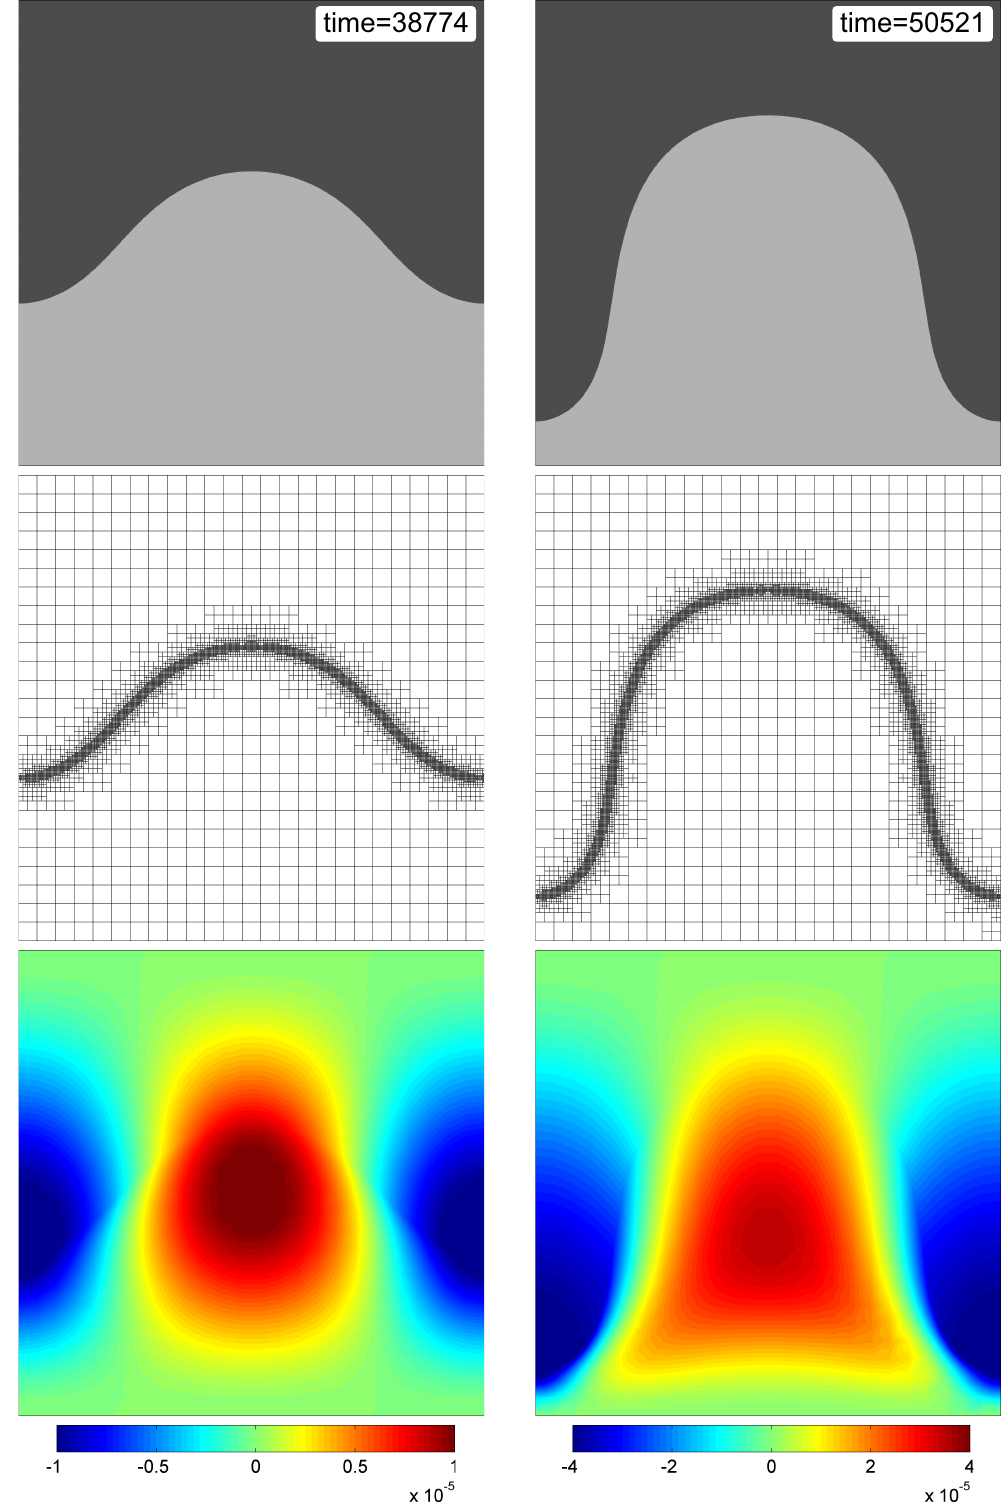
= 10 3 . top : material plot; η 2